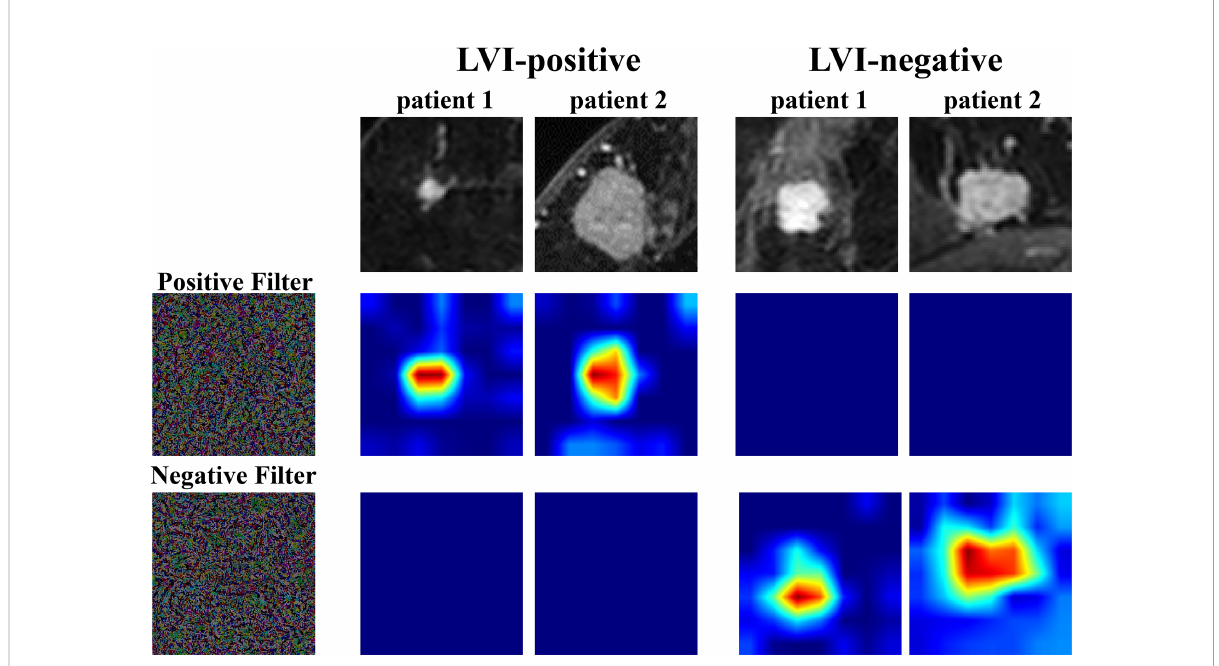
FIGURE 3 Attention map visualization of LVI-positive and LVI-negative lesions. The fi rst row shows the fi rst postcontrast images from two LVI-positive lesions and two LVI-negative lesions. The second and third rows show the attention maps of the input tumor images. The positive fi lter has a strong response to LVI-positive lesions, and the negative fi lter has a strong response to LVI-negative lesions. LVI, lymphovascular invasion.